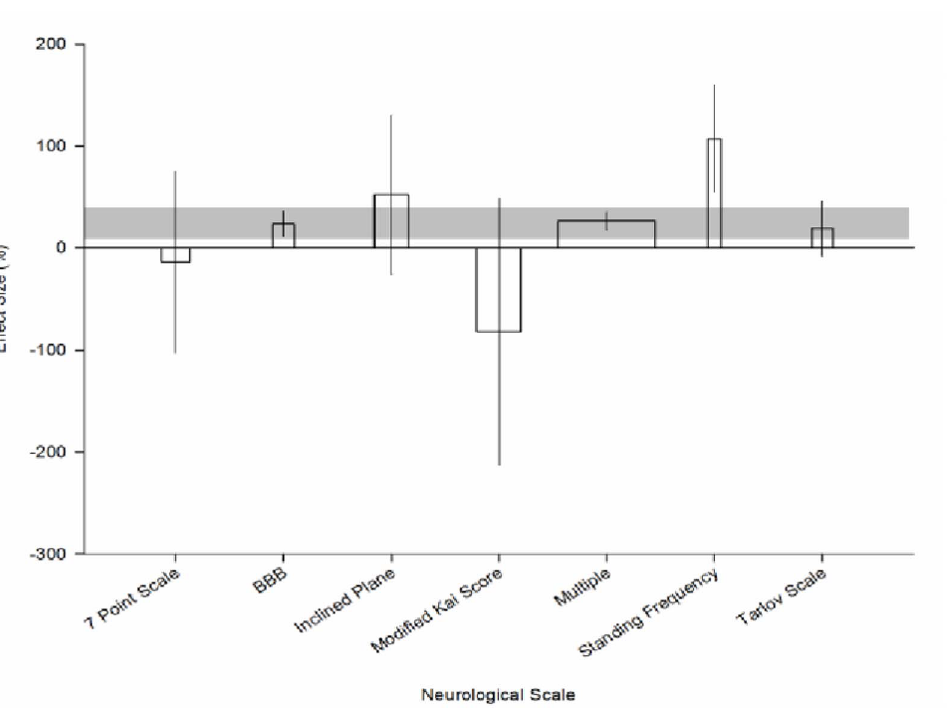
Figure 5. Heterogeneity within systemic hypothermia experiments. Effect of neurobehavioural scale used on effect size reported for experiments employing systemic hypothermia. The shaded gray bar represents the 95% confidence limits of the global estimate. The vertical error bars represent the 95% confidence intervals for the individual estimates. The width of each bar reflects the log of the number of animals contributing to that comparison. Each stratification accounts for a significant proportion of the heterogeneity observed between studies.